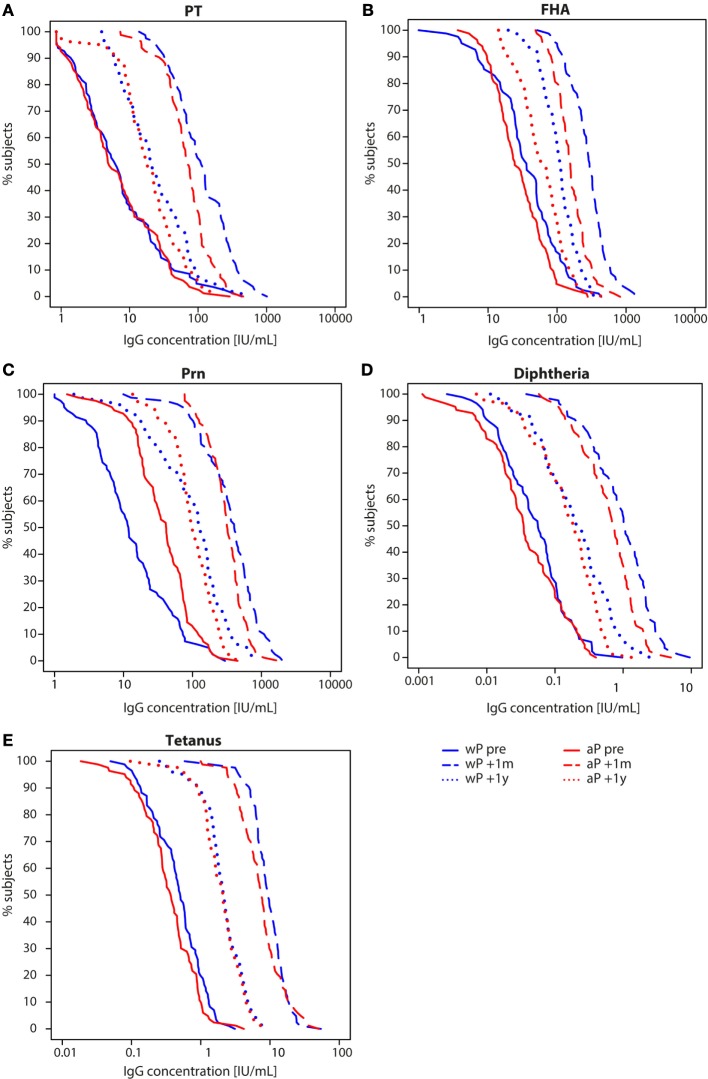
Reverse cumulative distribution curves of IgG antibody levels in children 9 years of age before and after a Tdap booster vaccination. Reverse cumulative distribution curves of (A) pertussis toxin (PT), (B) filamentous hemagglutinin (FHA), (C) pertactin (Prn), (D) diphtheria toxoid, and (E) tetanus toxin-specific IgG levels of whole-cell pertussis (wP)- (blue) and acellular pertussis-primed (red) children 9 years of age before (solid lines), 1 month (striped lines), and 1 year (dotted lines) after a preadolescent Tdap booster vaccination. Note, data of PT, FHA, and Prn for wP-primed children were previously published (26).